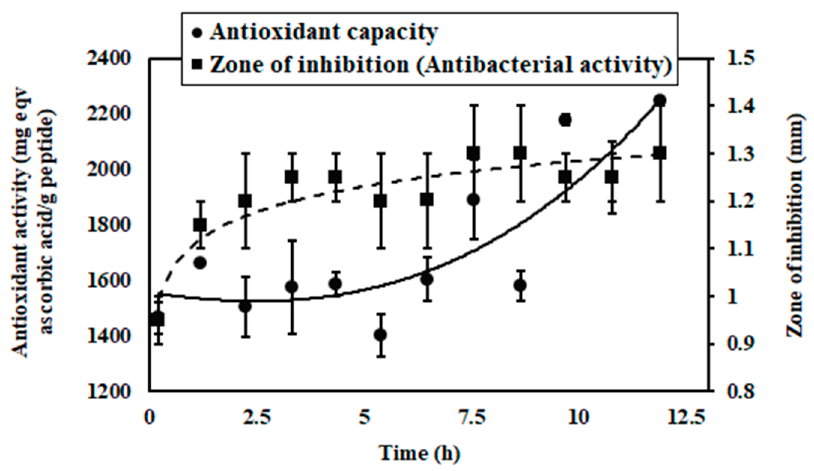
Figure 7. Antioxidant capacity and zone of inhibition of membrane permeate in di ff erent process time.